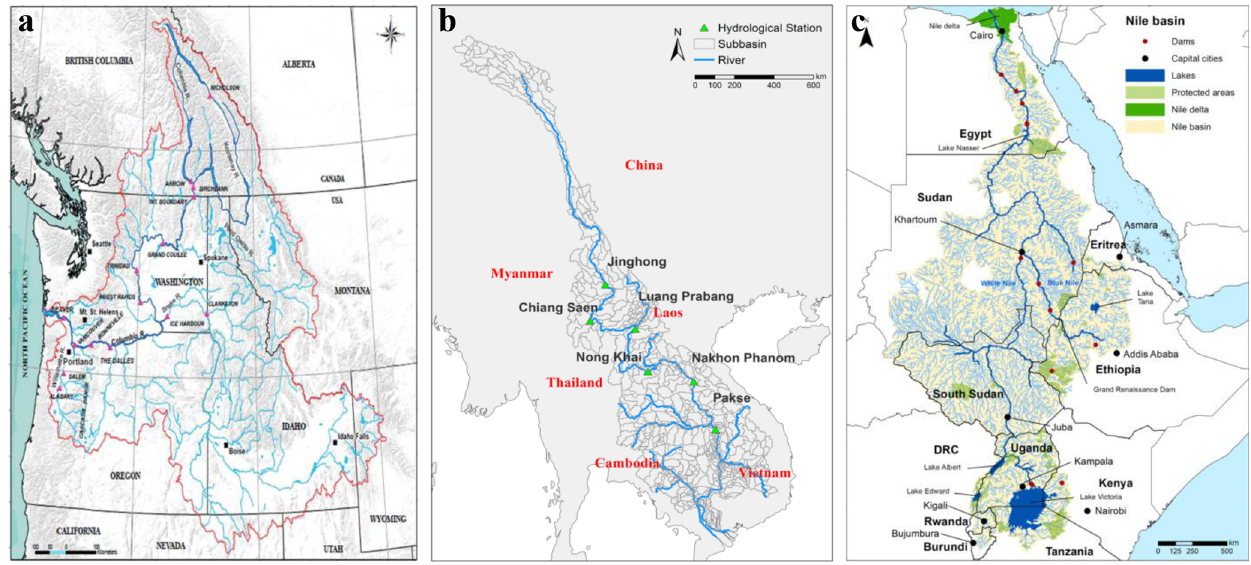
Figure 3. The case study examples, (a) Columbia River (Jay and Naik, 2011), (b) Lancang–Mekong River (Lu et al., 2021), (c) Nile River (Allan et al., 2019), used in this